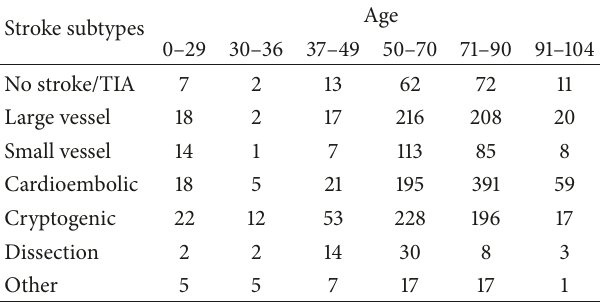
Table 1: Breakdown of stroke patients by